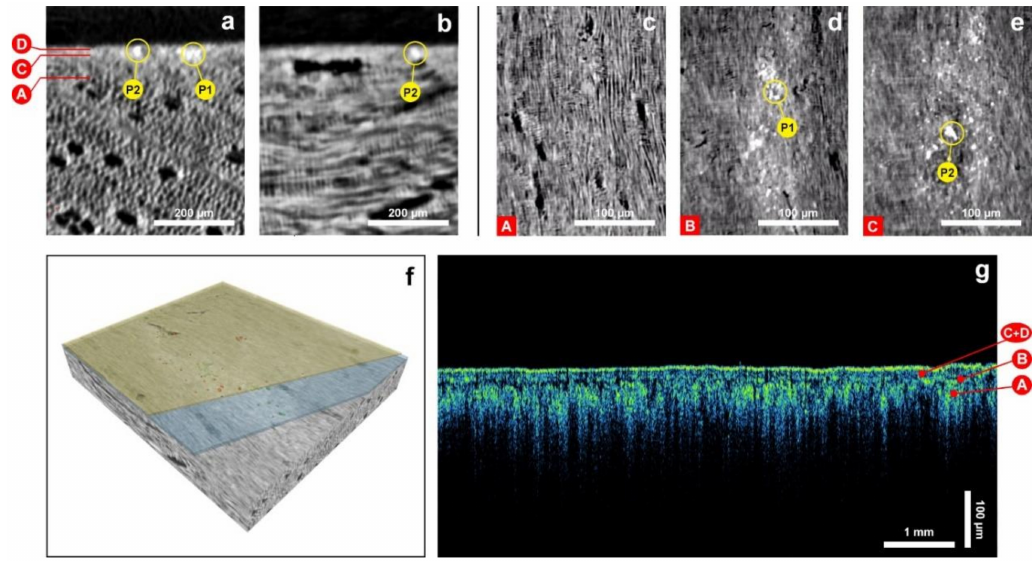
Figure 4. Fragment F13, Gasparo da Sal ò . ( a , b ) Transverse and tangential slices from the SR-micro-CT volume showing the levels for radial slices reported in ( c – e ) and the different kinds of particles embedded in the finishing layers. ( c – e ) Radial slices from the SR-micro-CT volume showing the finishing layers discussed in the text. ( f ) Virtual reconstruction based on SR-micro-CT volume. Layer C (as in Figure 4a) is colored in blue with green particles and layer D is shown in yellow with red particles. ( g ) OCT tomogram presented in false-color scale (see Section 2.2 for details). On the wood substrate A, a preparation layer B appears as the dark, non-scattering structure; the varnish shows two barely visible layers (C + D) with fine scattering